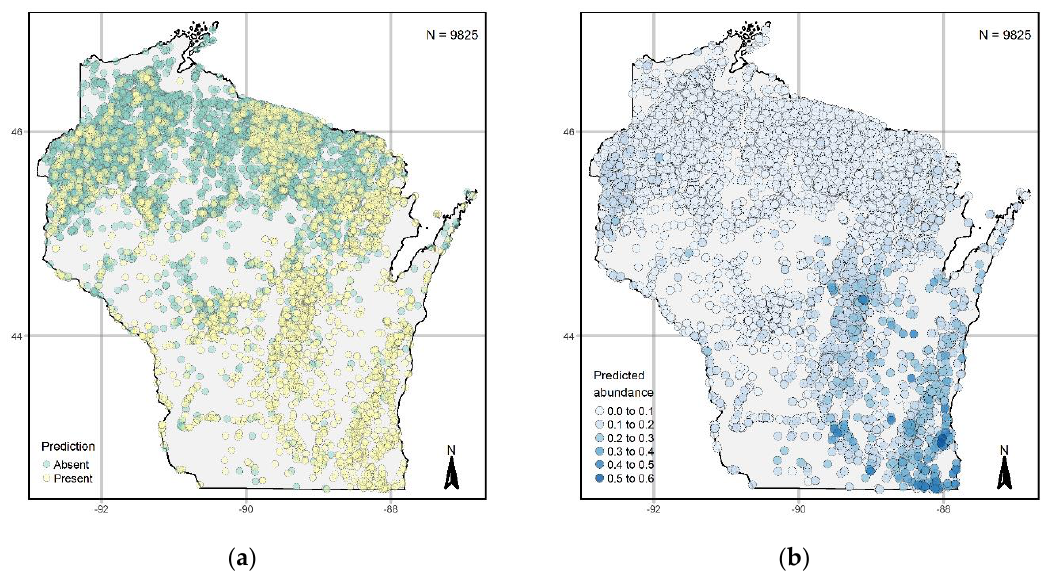
Figure 3. Occurrence and abundance models developed on N = 657 and extended to 9825 lakes over 1 ha in surface area. Eurasian watermilfoil occurrence predictions ( a ) generated using a bias-reduced GLM. The probability threshold distinguishing likely presences from absences was set at 0.246 to minimize the chance of false absences. Eurasian watermilfoil abundance predictions ( b ) generated using a beta regression